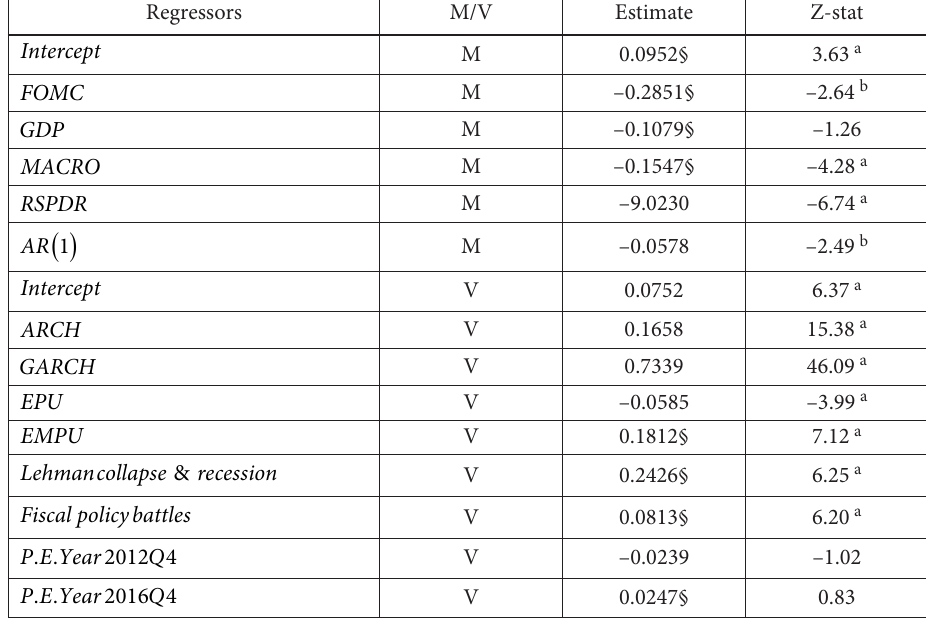
Table 11. Economic policy uncertainty and SPDR gold volatility index